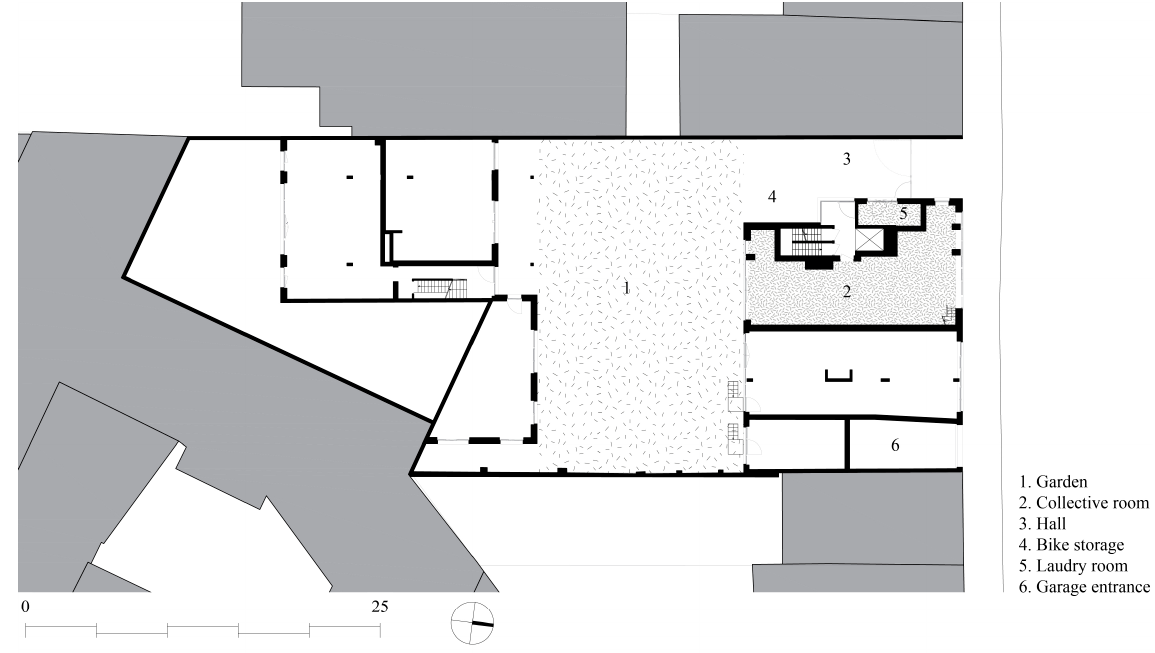
Figure 3. L’Echappée, ground floor—shared spaces (drawn by the authors, 2019). Figure 3. L’Echapp é e, ground floor—shared spaces (drawn by the authors,